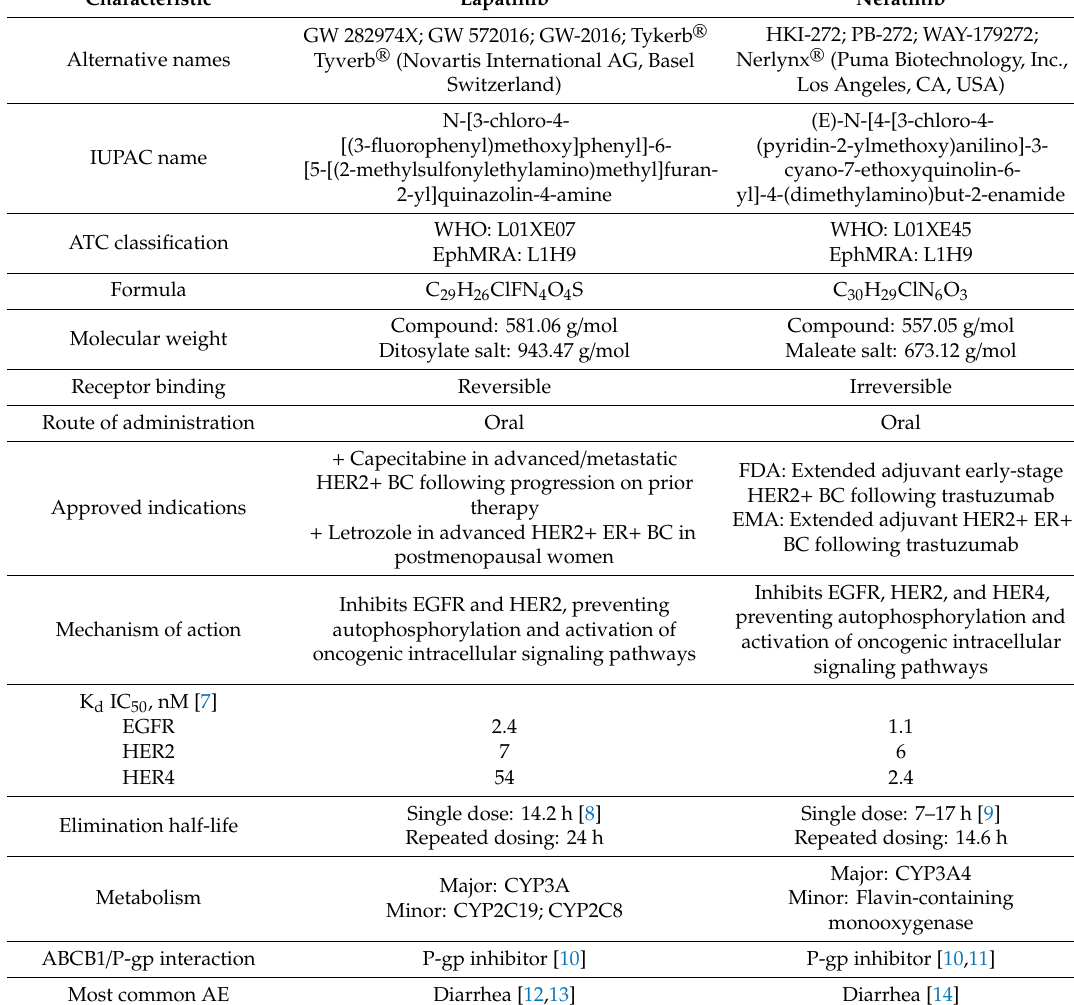
Table 1. Comparison of lapatinib and